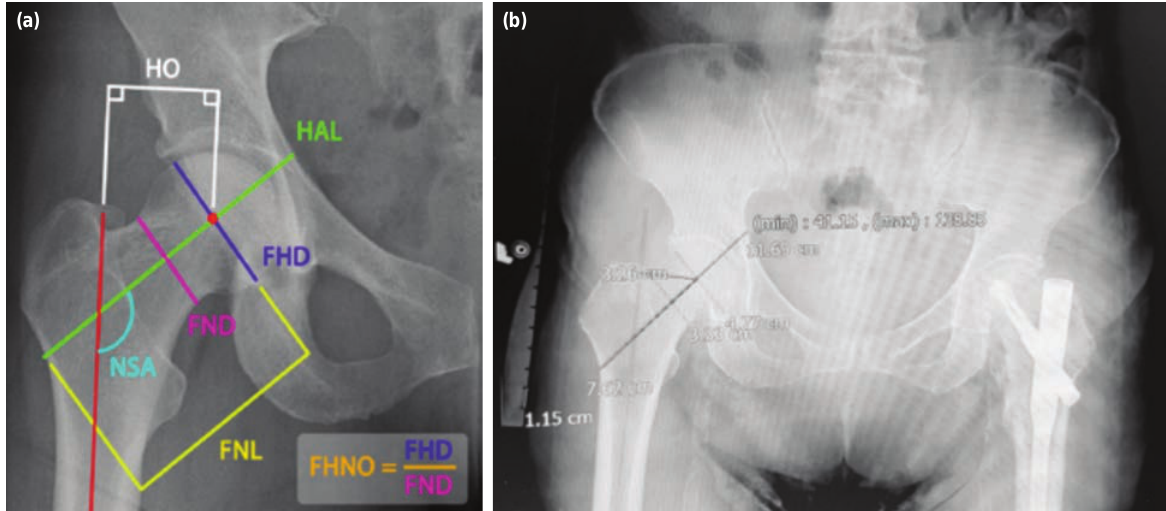
(a) Schematic diagram of radiographic measurements. (b) Actual sample radiograph and measurement Fig. 2: